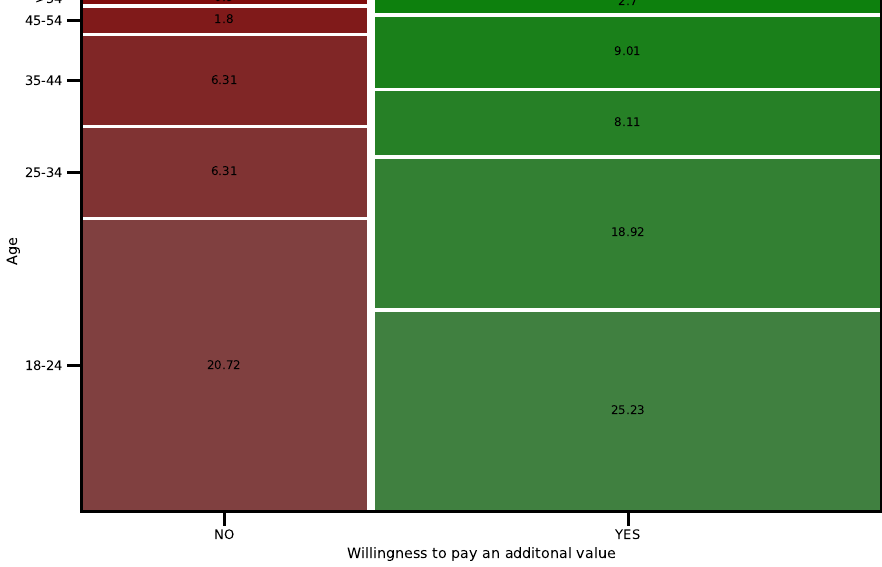
Figure 4. Mosaic plot of the willingness to pay an additional value based on age.